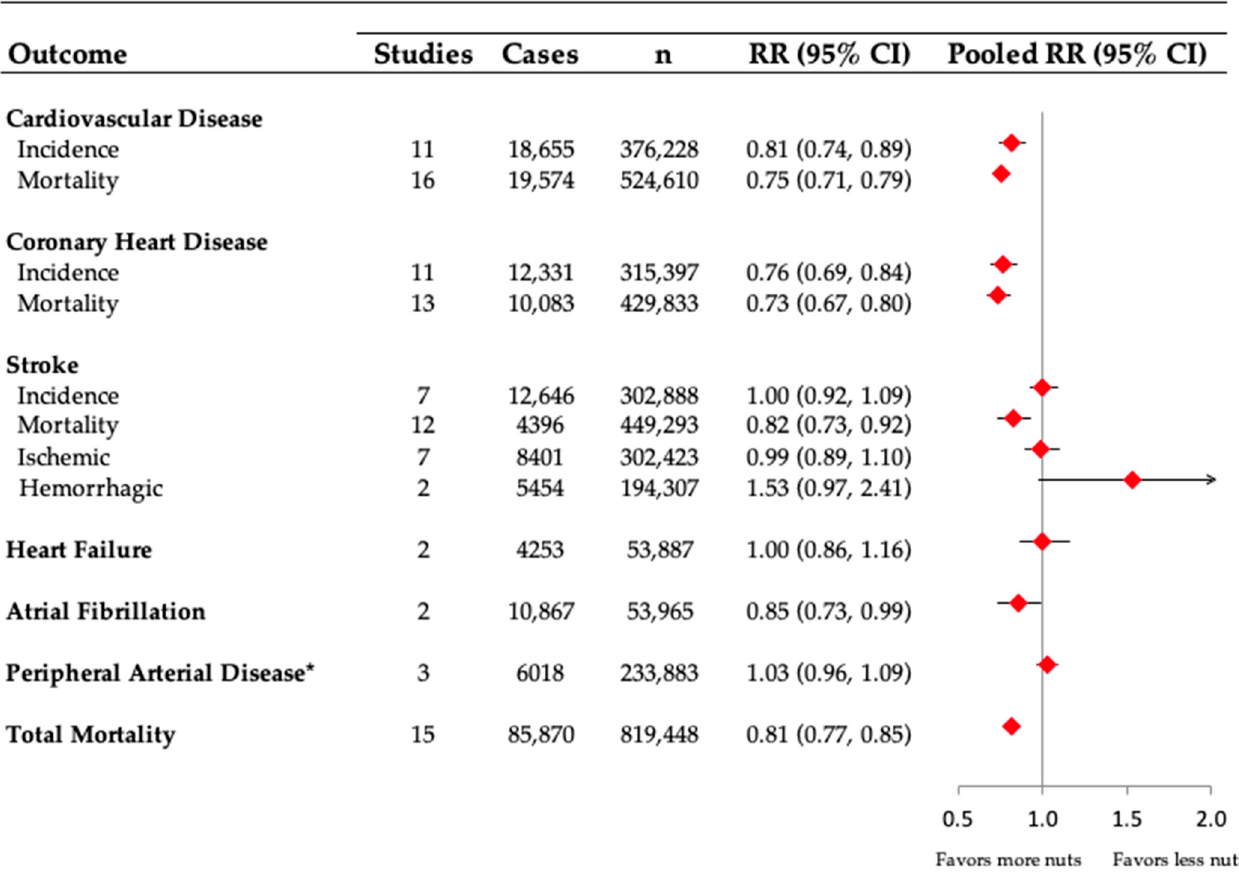
Figure 1. Summary of the pooled effect estimates of prospective cohort studies assessing the association between high and low consumption of nuts and risk of cardiovascular disease outcomes and total mortality. Figure adapted from Figure 2 in [21]. Pooled risk estimate is represented by the diamond. * To obtain summary estimates for peripheral arterial disease, we used generic inverse variance (fixed effects) to pool the natural log-transformed RRs of the extreme quantiles. Abbreviations: CI = confidence intervals; RR = relative risk